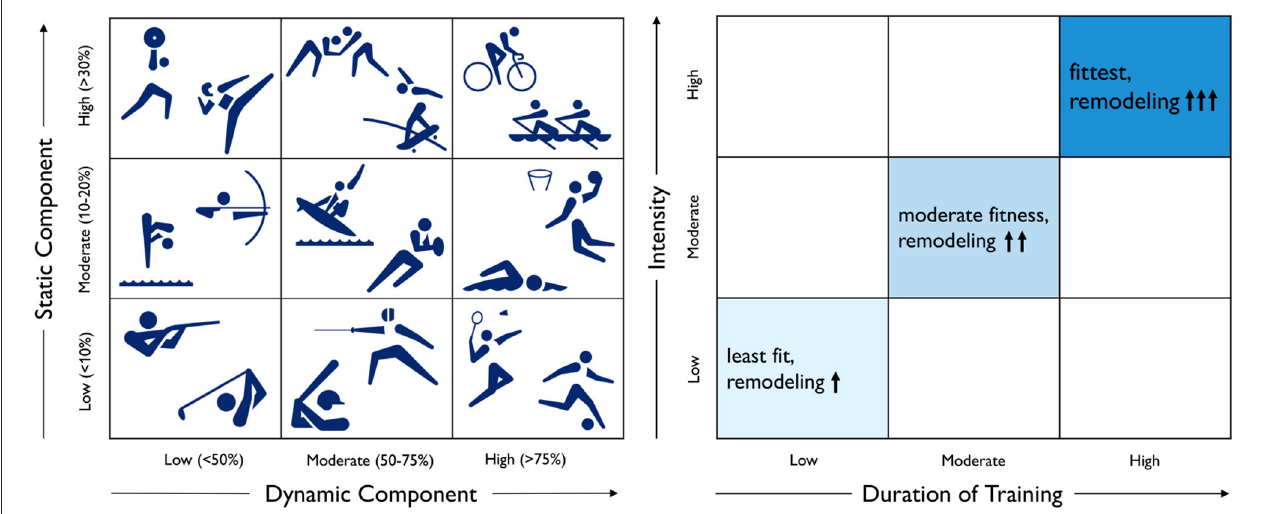
FIGURE 5 | Physiological adaptation to dynamic and static exercise and training duration and intensity. According to Mitchell’s classifications, left, dynamic exercise is associated with an increase in cardiac output, while static exercise is associated with an increase in blood pressure. According to Beaudry’s classifications, right, the degree of cardiac adaptation depends on the duration and intensity of training.